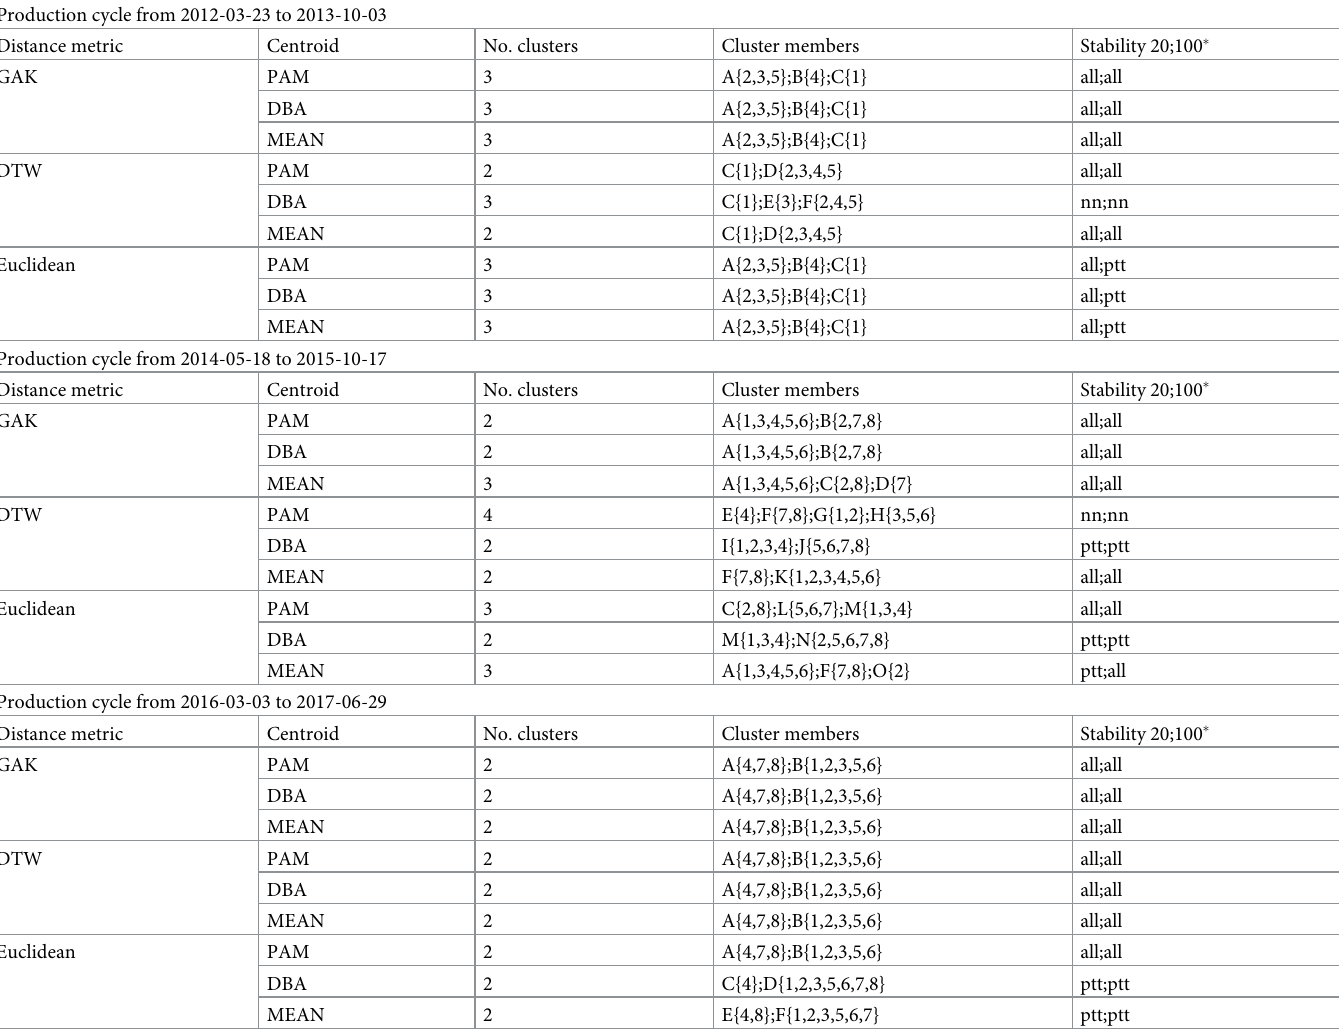
Table 2. Clustering results for Farm I, with cluster membership as shown in the plots in Figs 2, 3 and 4. The most stable clusters are identified per cycle, alphabetically. Production cycle from 2012-03-23 to